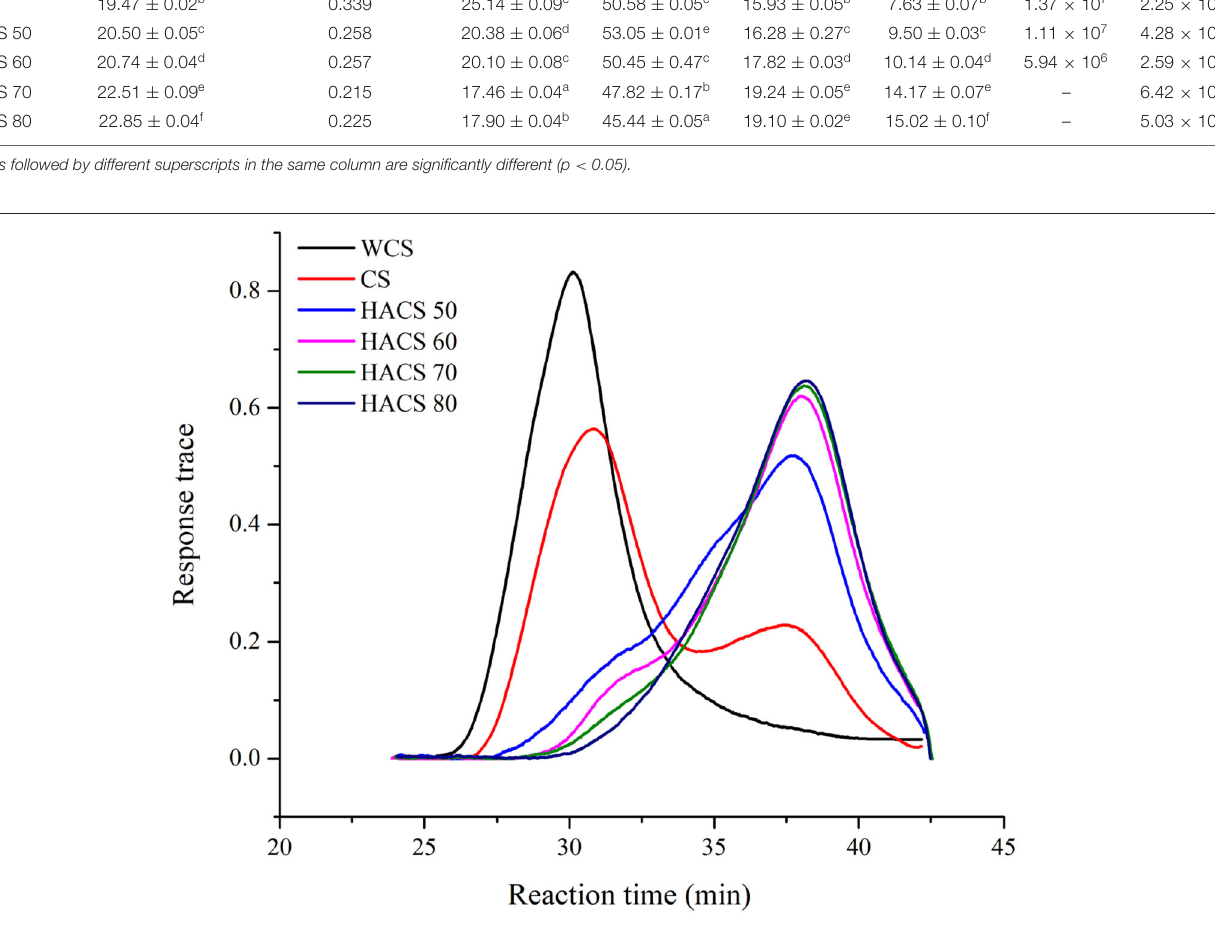
FIGURE 5 | Weight-average molecular weight of corn starch with different amylose content. consistent increasing trend, which indicates that the RS content of starch is closely related to the thermal stability of